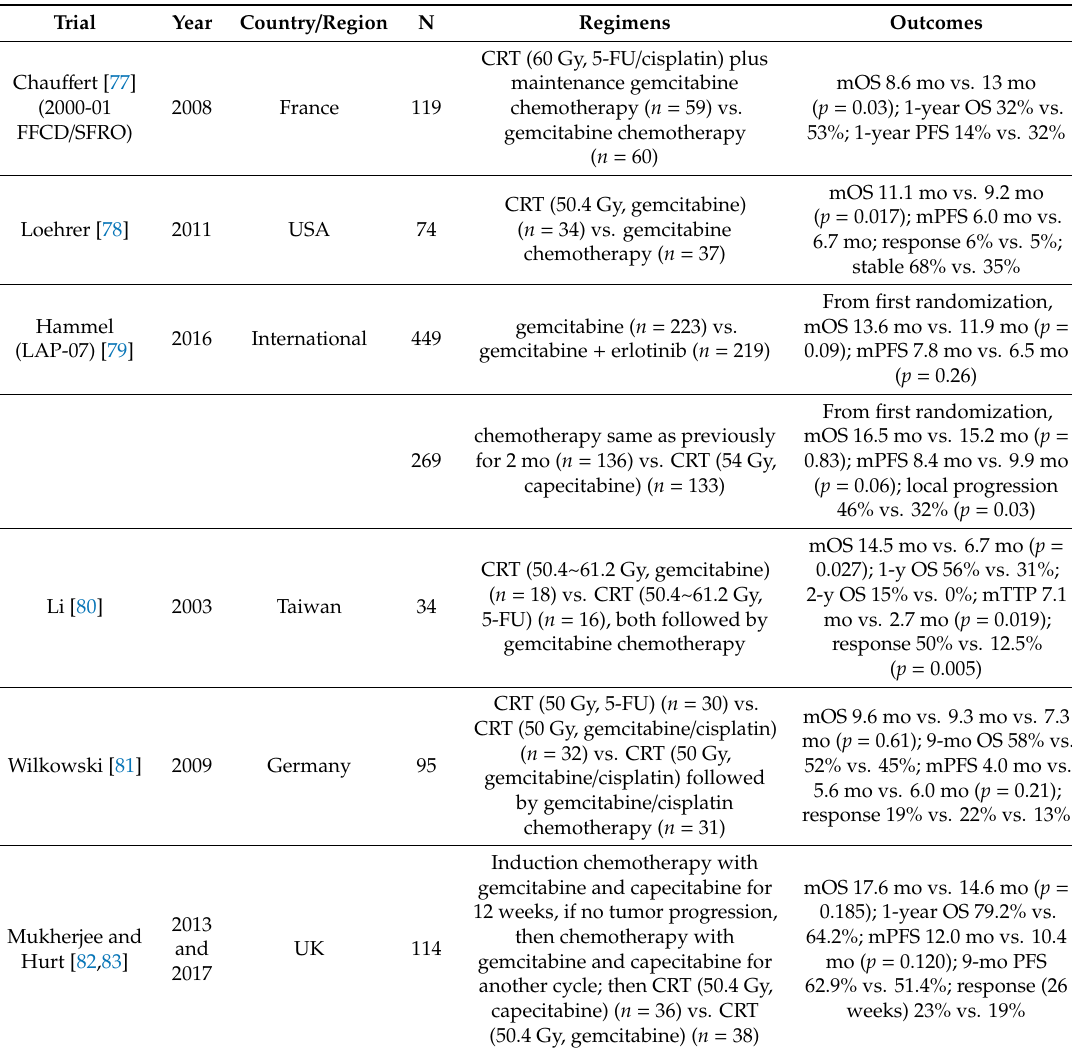
Table 4. Summary of randomized controlled trials concerning chemoradiation in patients with locally advanced pancreatic